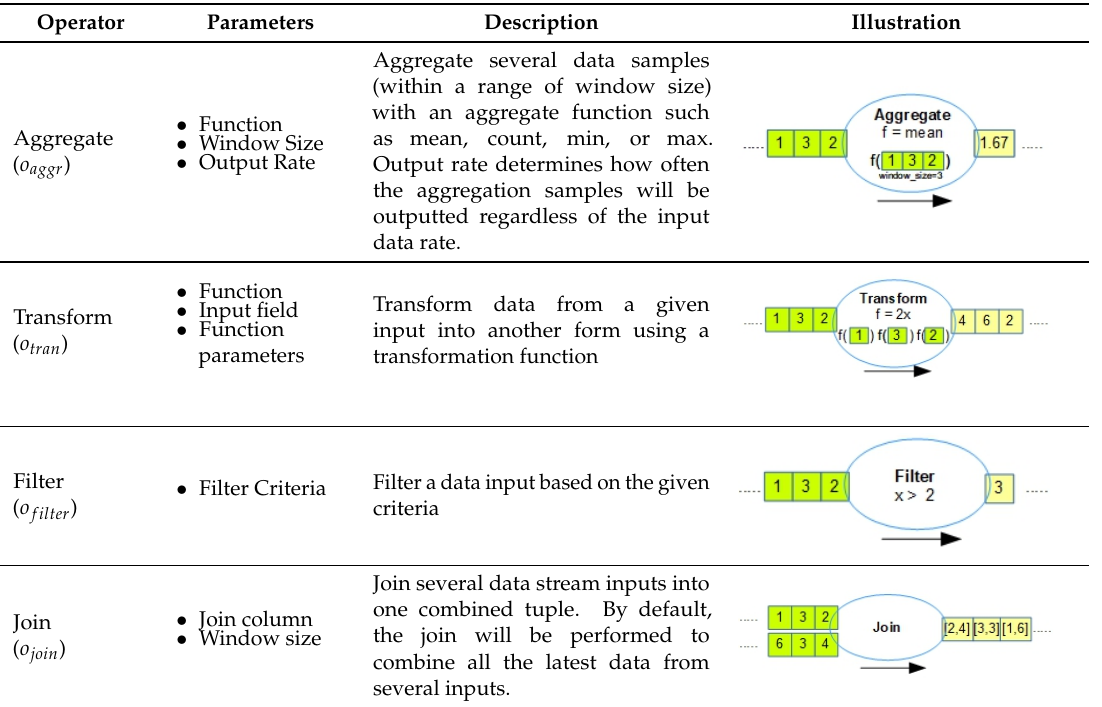
Table 1. Query operators supported in